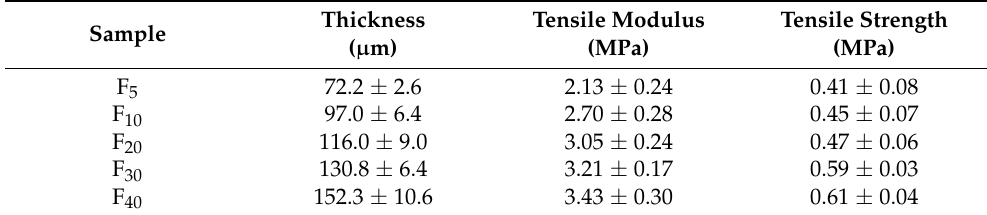
Table 2. Thickness, tensile modulus and tensile strength of films F 5 , F 10 , F 20 , F 30 and F 40 . The measurements were carried out at least in triplicate, and the results are reported as mean val- ues ± standard